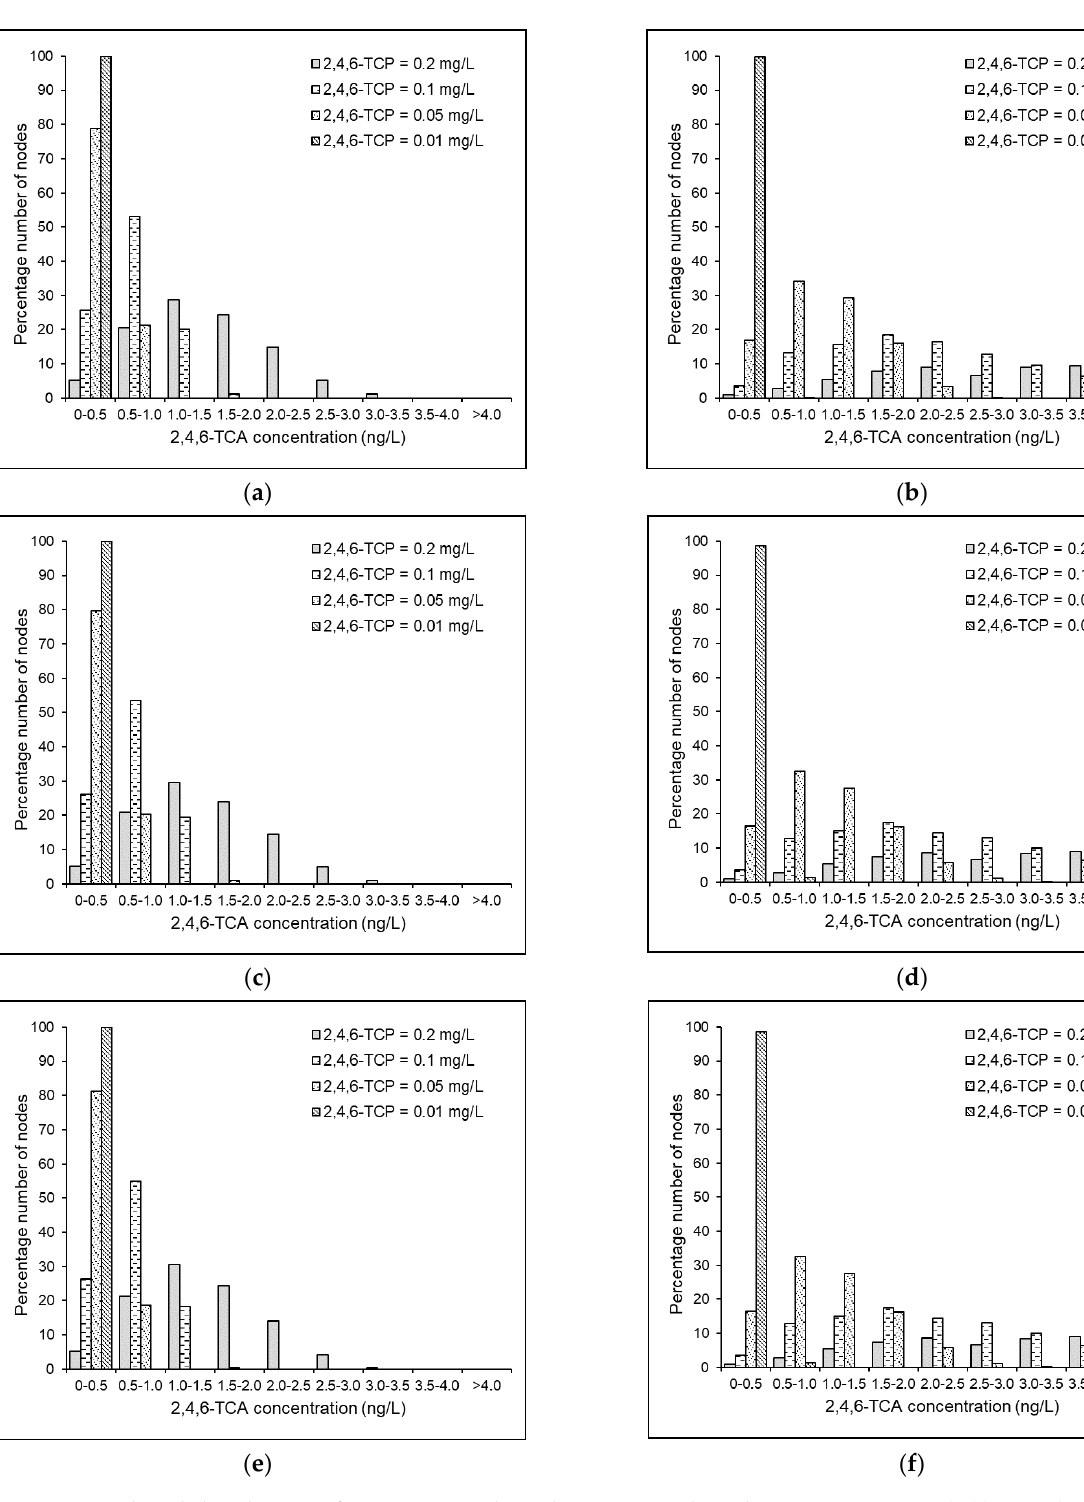
Figure 3. Predicted distribution of 2,4,6-TCA in the Balerma network under 𝑇 = 25 °C, 𝑆 𝑜 = ( a , b ) 0.01, ( c , d ) 0.1, and ( e , f ) 0.3 mg/L, Scenario ( a , c , e ) I and ( b , d , f ) II, and under non-chlorinated condition.